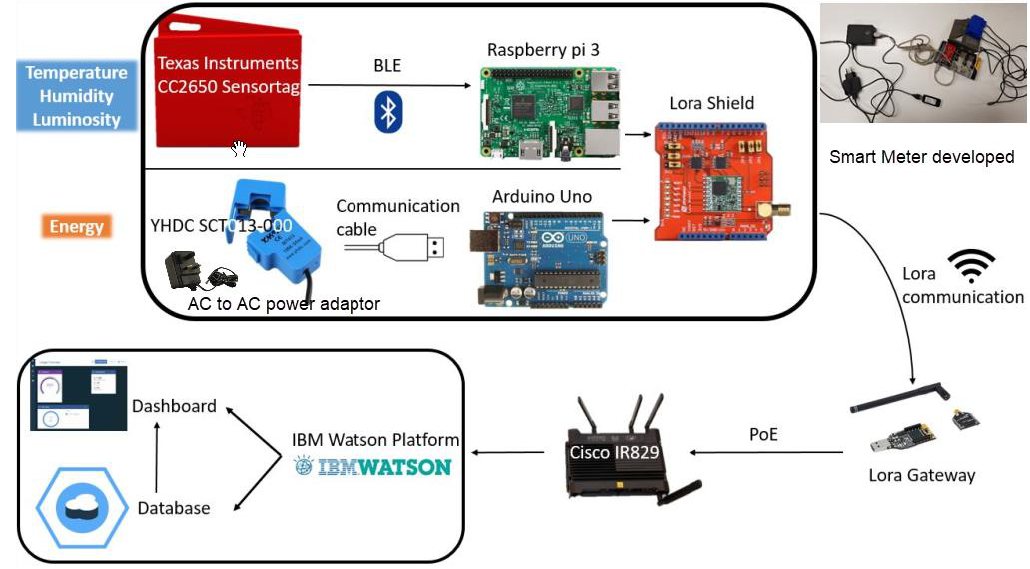
Figure 4. Smart meters for electricity measurement and a temperature/luminosity sensor with a Lora network, sending data to IBM Watson.